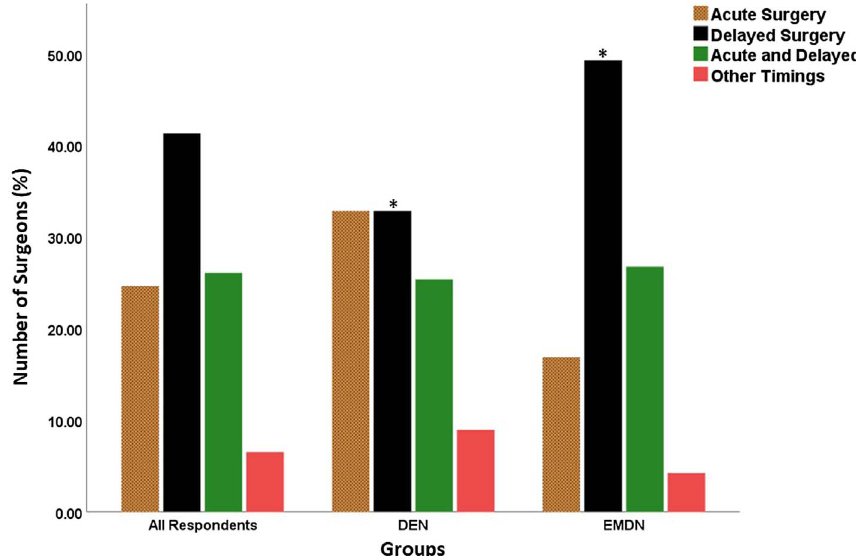
Figure 3. Timing of the aMLKI surgeries as reported by the participating surgeons. Signi fi cant differences are denoted by *.